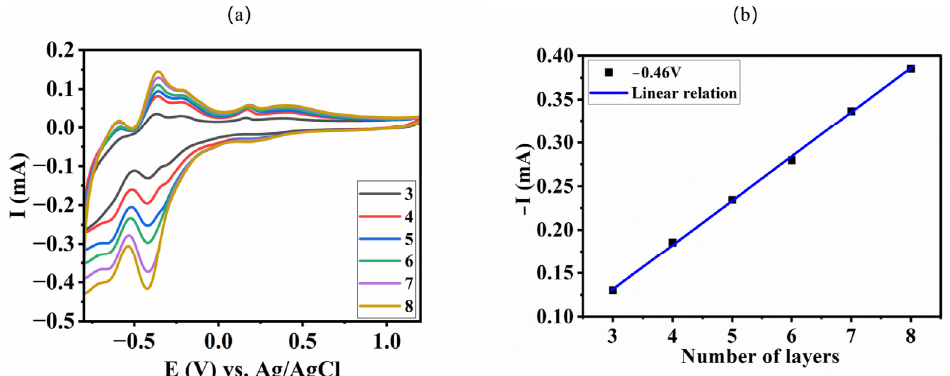
Figure 4. CV curves of the ITO/(Cu 4 P 4 W 30 /PDDA-GO) 3–8 electrode in buffer solution at pH = 3 with scan rate of 50 mV · s − 1 ( a ) and the linear relationship between the peak currents at − 0.43 V and the layer number ( b ). The black square corresponds the current per layer number and the blue line corresponds the fitted linear relationship.